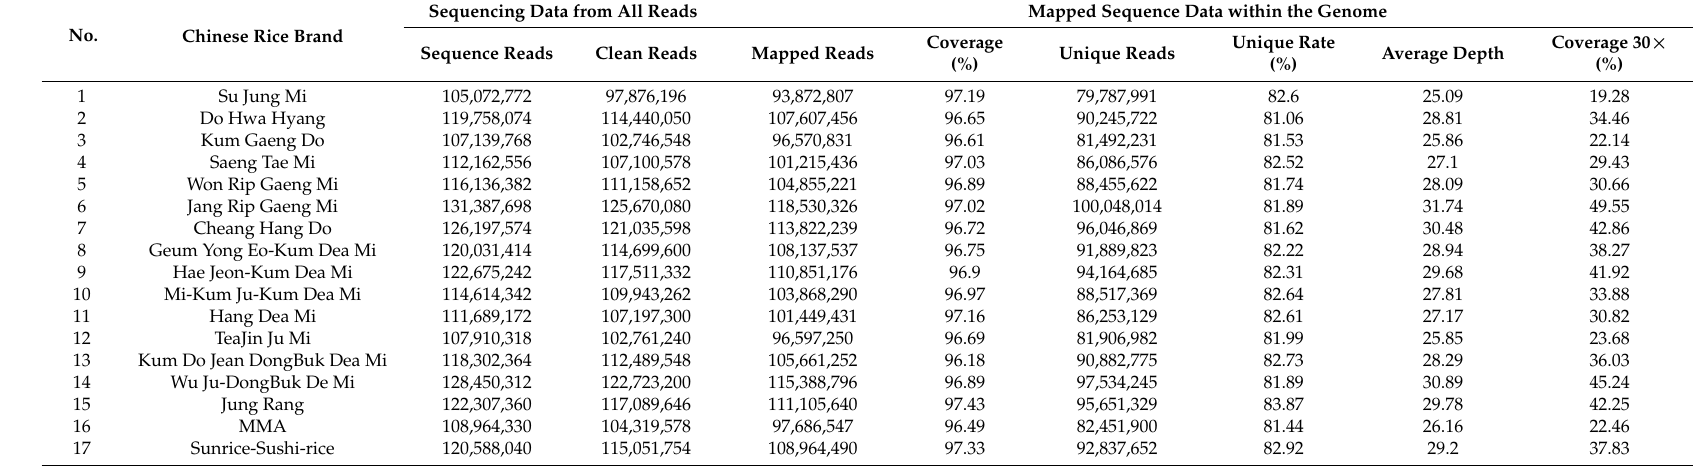
Table 1. Sequence information for the 17 Chinese rice cultivars obtained by whole-genome re-sequencing